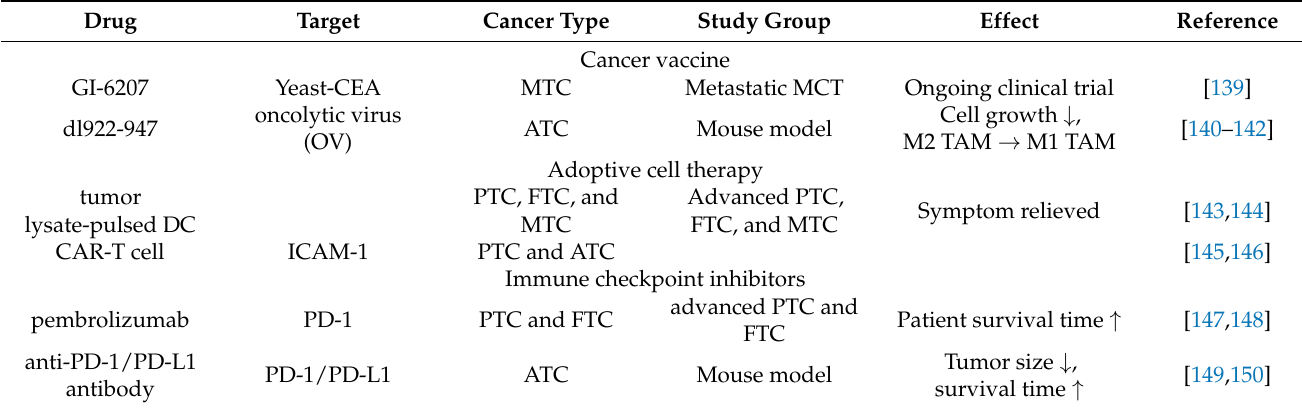
Table 2. Immune cell modulator in thyroid